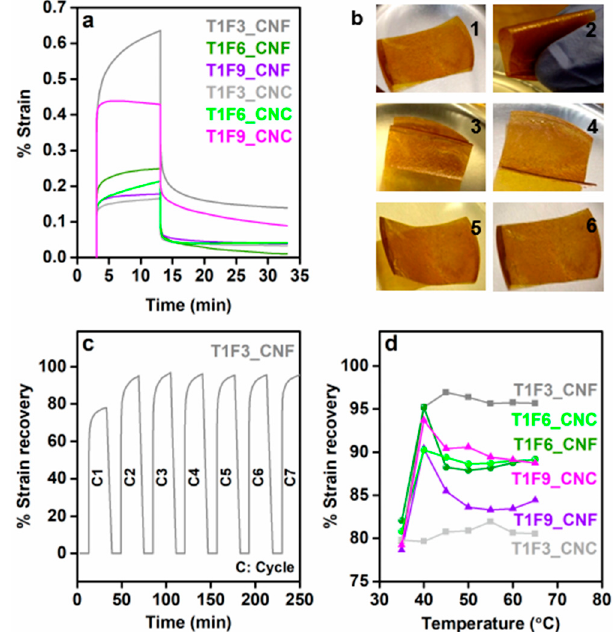
Figure 9. ( a ) % creep strain vs. time plots for CNF- and CNC-reinforced biocomposites at room